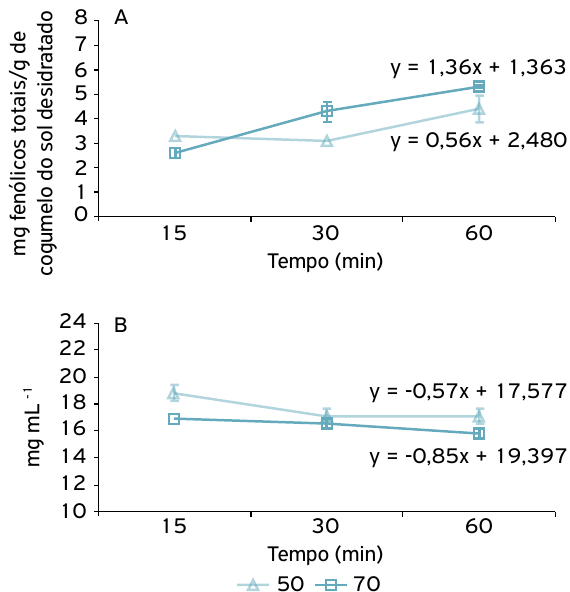
Figura 1. Fenólicos totais (A) e atividade antioxidante in vitro representada pela concentração necessária